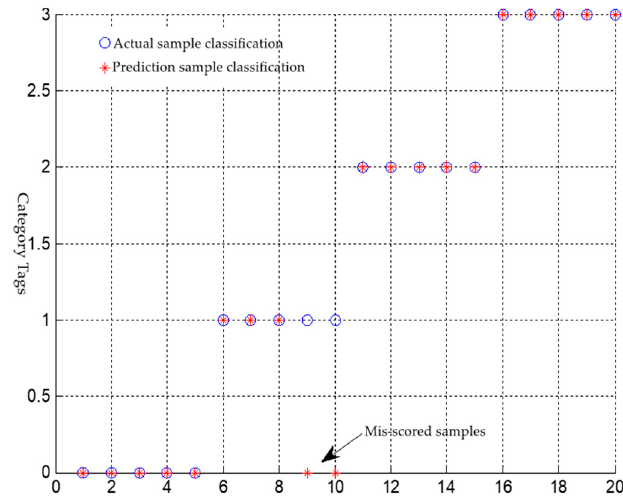
Figure 11. Test sample data classification results.